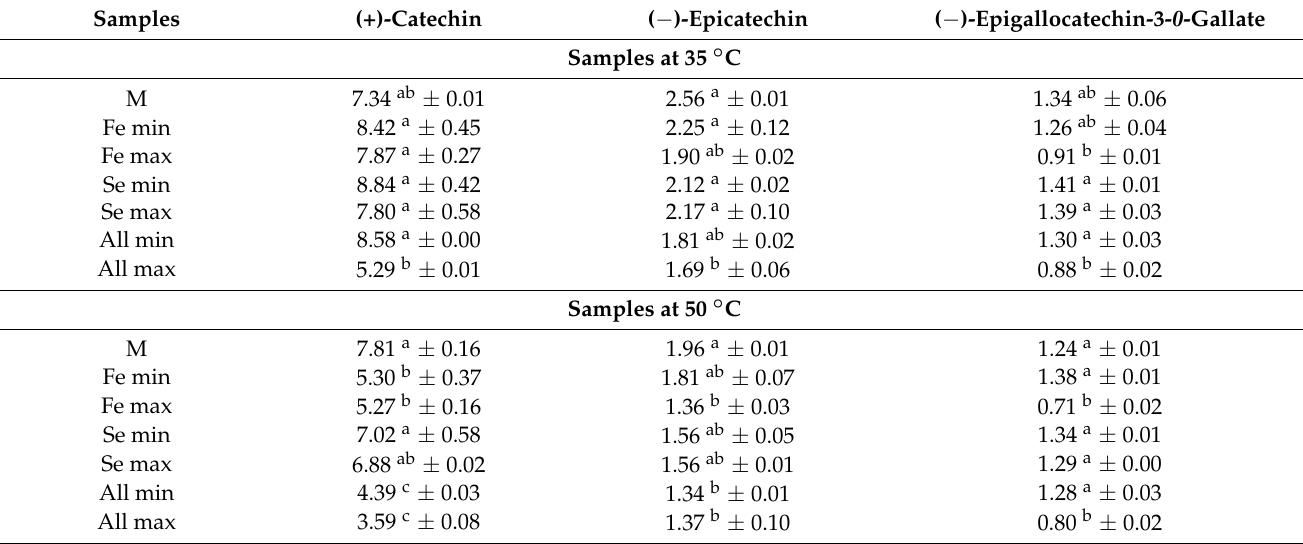
Table 3. Change of (+)-catechin, ( − )-epicatechin, and ( − ) epigallocatechin-3–0-gallate concentration * (mg/L) of the samples during 12 days of heating at 35 and 50 ◦